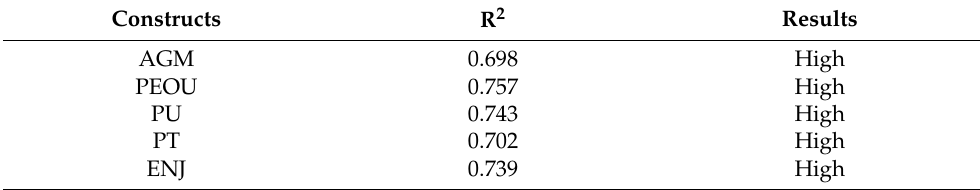
Table 9. R 2 of the endogenous latent variables.